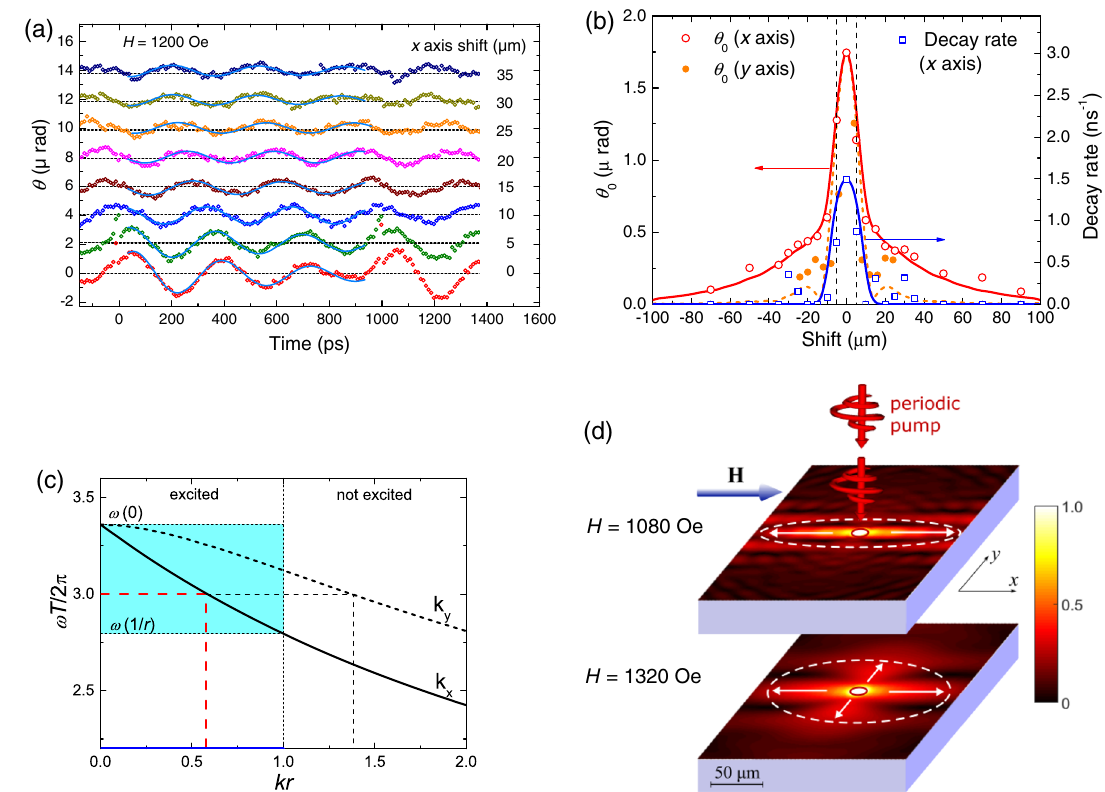
FIG. 4. Generation of spin waves by a cloud of periodically pumped, coherently oscillating spins. (a) Magnetization oscillations observed in sample 1 in the probe beam shifted by 5 – 35 μ m relative to the pump beam along the external magnetic field. Solid curves are fits with a decaying sine function. The fit parameters are given in Table SII (see Ref. [30]). Here, H ¼ 1060 Oe. (b) Oscillation amplitude (red and orange) and decay rate (blue) at different distances between the pump and probe for the probe shifted along the x axis (open symbols and solid lines) and the y axis (filled symbols and dashed lines). The experimental data are shown by the symbols, while the calculation results are given by the lines. ( с ) Calculated dispersion of the SWs propagating along the x and y directions. The blue region indicates the range of k generated by a single laser pulse with spot radius r . The dispersion was calculated using the theoretical model in Ref. [35]. (d) Calculated distribution of m z in SWs launched at H ¼ 1060 Oe ( ω T= 2 π ¼ 3 ) and H ¼ 1320 Oe ( ω T= 2 π ¼ 3 . 75 ). In the former case, SWs are generated in a narrow region along H (phenomenon of SW directionality), while in the latter one, SWs are generated in the perpendicular direction as